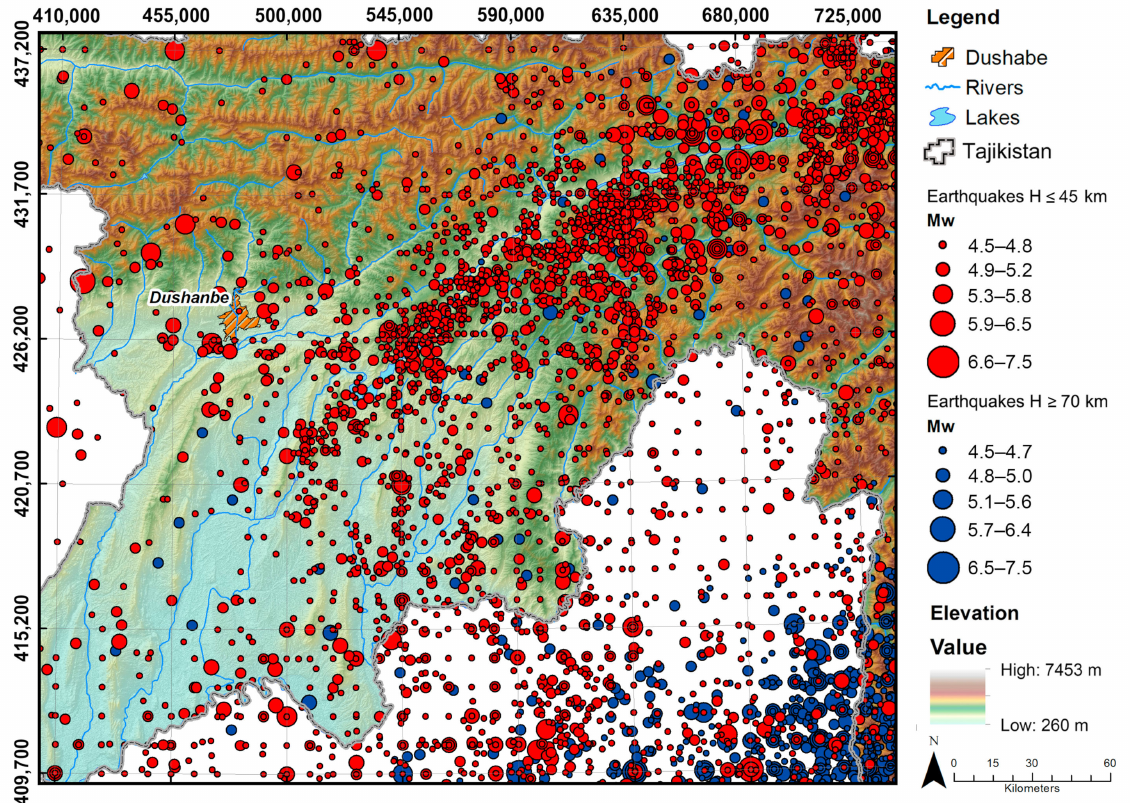
Figure 4. Epicenters of shallow (focal depths ≤ 45 km; marked in red) and deep (focal depths ≥ 70 km; marked in blue) earthquakes from the Central Asia Seismic Risk Initiative, Earthquake Modeling for Central Asia Catalogue (CASRI- EMCA; [34,35]) over the period from 850 until 2015, and updated from USGS catalogue (U.S. Geological Survey) over the period from 2015 until